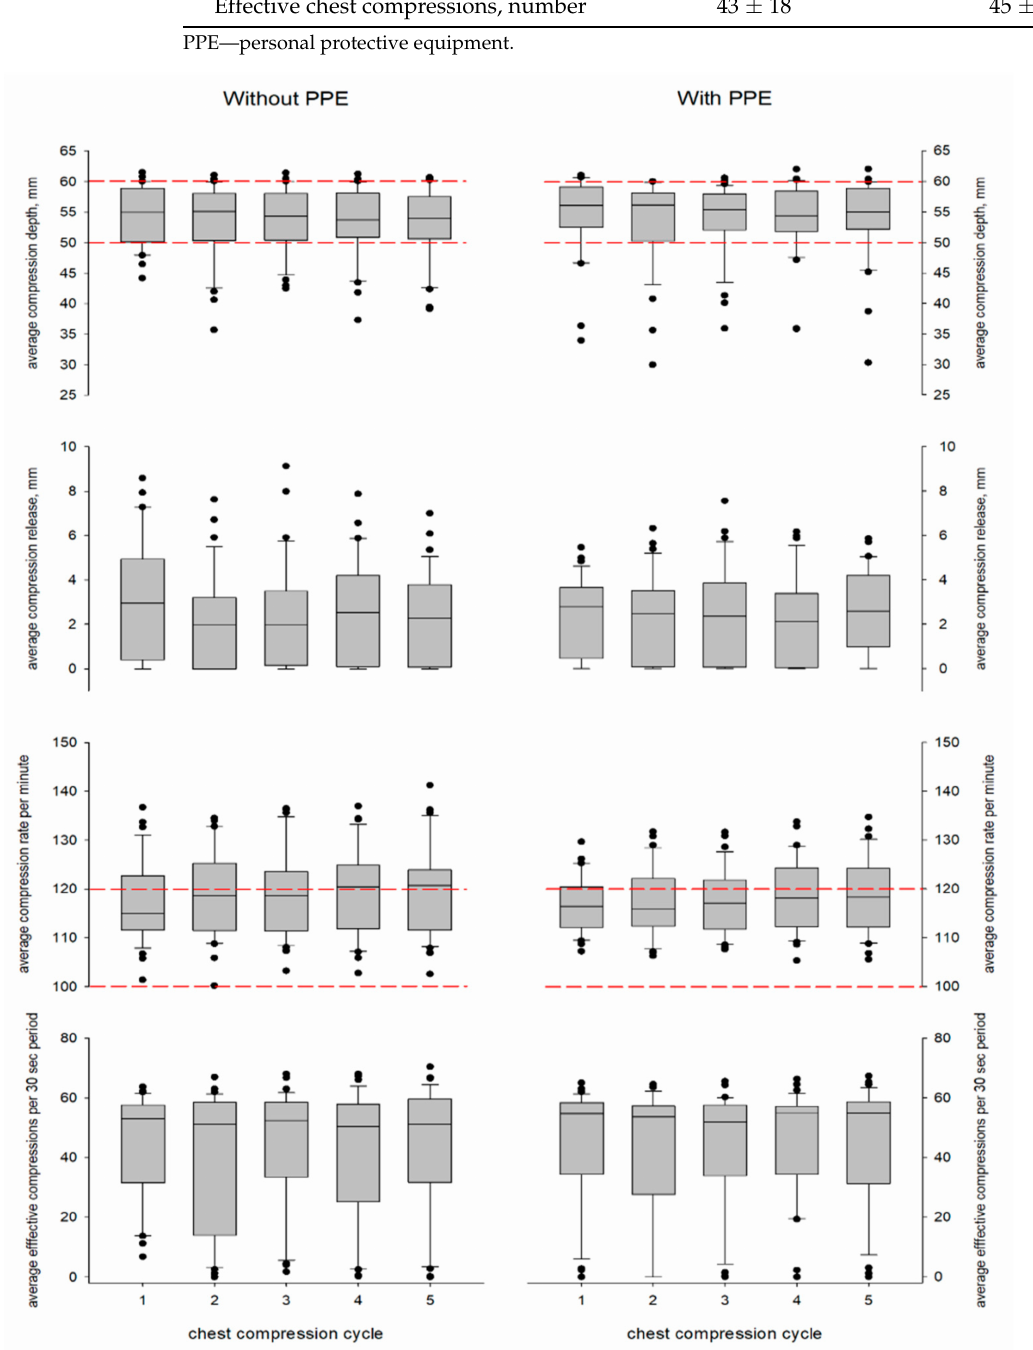
Figure 1. Boxplots of the evolution of chest compression depth, release, rate, and the number of effective chest compressions per consecutive 2 min cycle with and without personal protective equipment (PPE). The horizontal red dashed lines delineate the range of compression depth and rate recommended by the European Resuscitation Council guidelines [8]. The • represents the